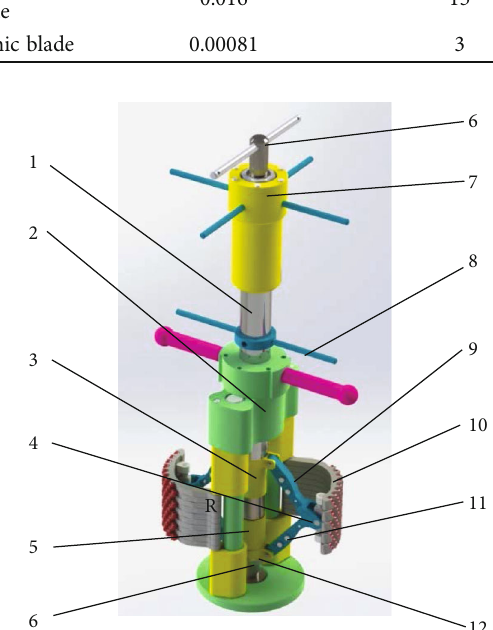
Figure 5: Mechanical structure. 1: Push rod; 2: main body; 3: